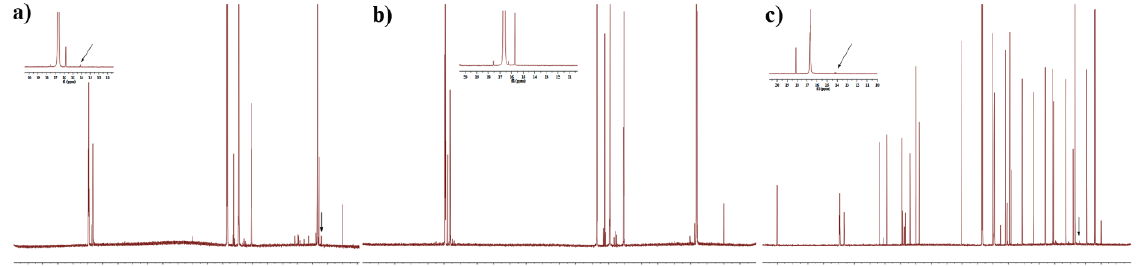
Figure 3. The 13C NMR of Vivitrol ® . There was a response peak at 14 ppm in PLGA with an ester end-cap ( a ) and Vivitrol ® ( b ), whereas there was none for the PLGA with an acid end-cap ( c ).